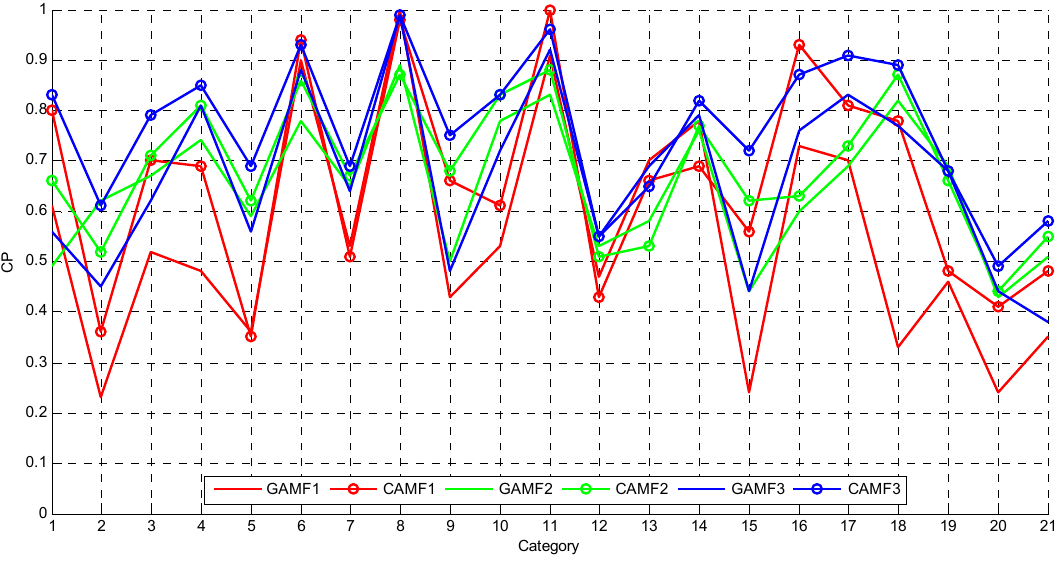
Figure 6. Class-level precision (CP) using different affinity metric fusion methods.